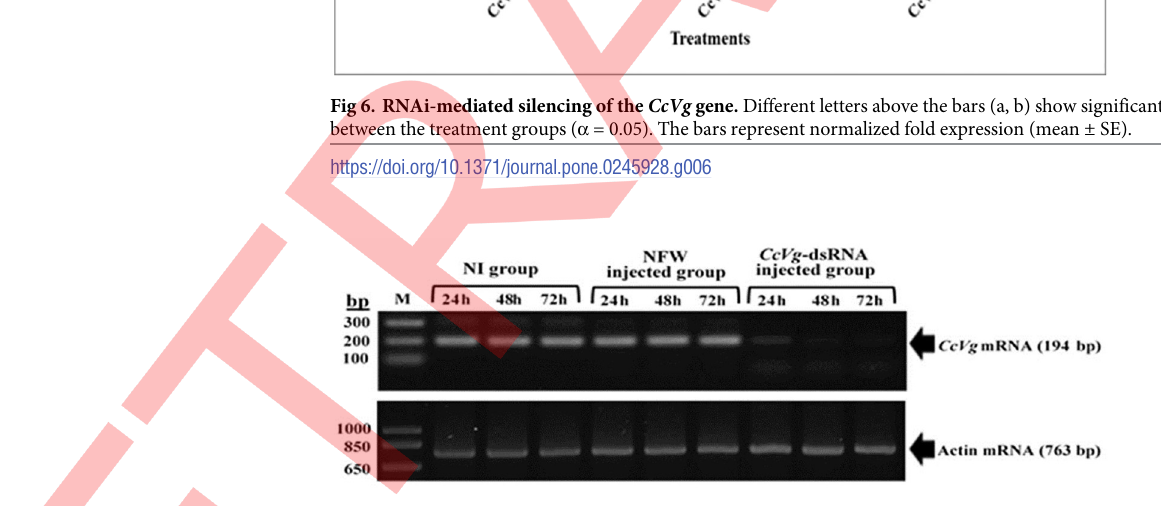
Fig 7. Validation of RNAi-mediated CcVg gene silencing through RT-PCR. Arrows on the right side indicate the amplified products of CcVg and actin genes. M = molecular marker, bp = base pair, d =